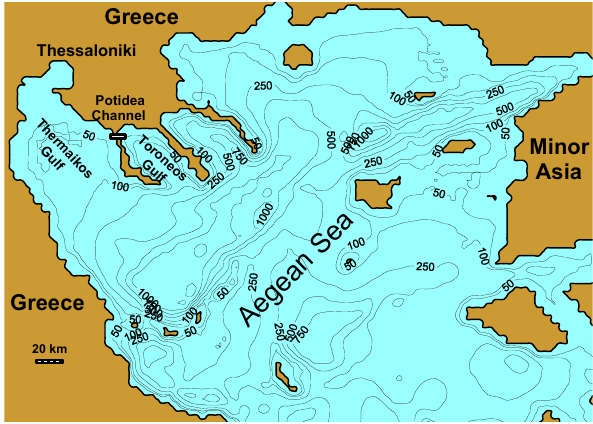
Fig. 1 The Northern Aegean Sea the modeled area, and the Potidea channel. Fig. 1. The Northern Aegean Sea the, modeled area and the Potidea channel.